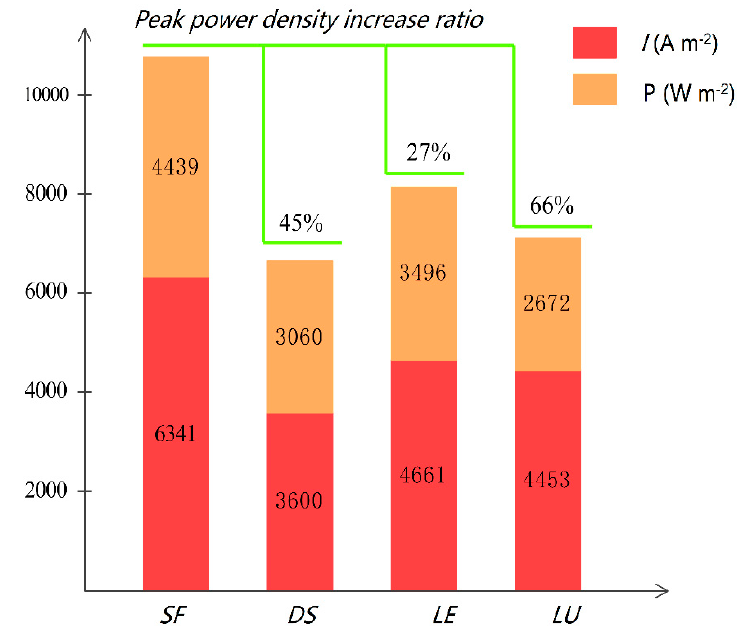
Figure 4. Peak power density of PEM fuel cells with various flow channels.